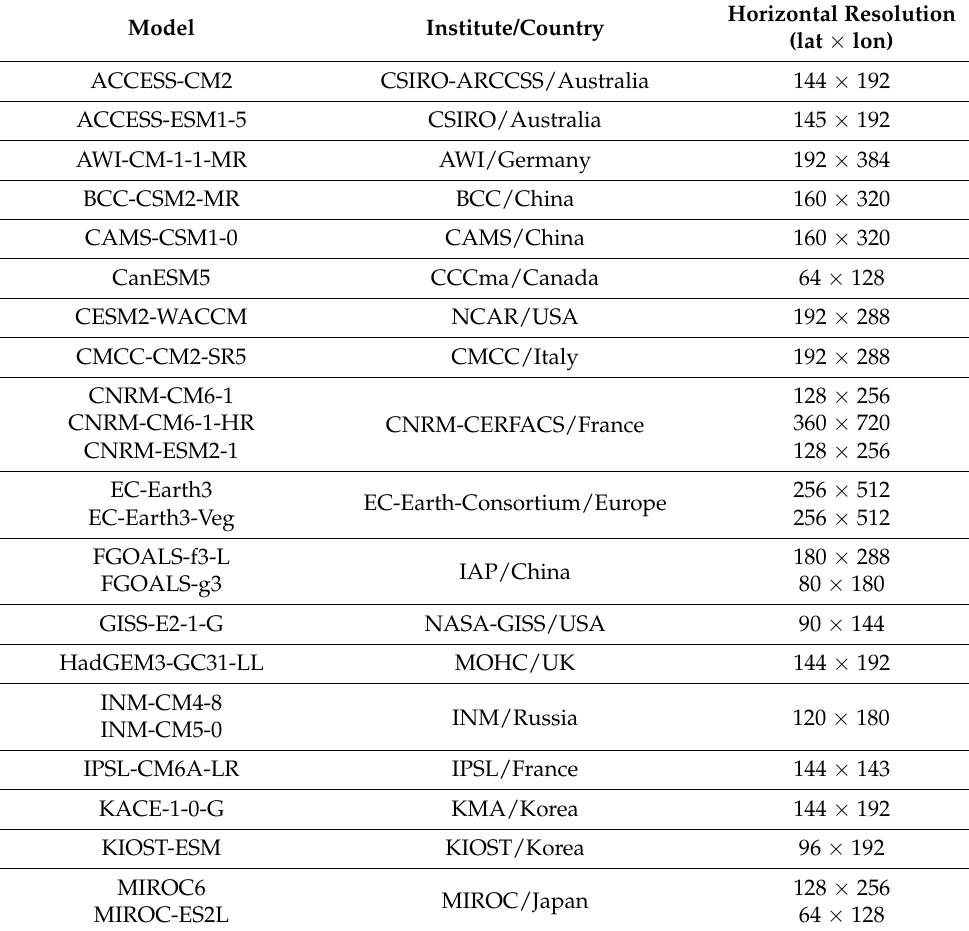
Table 1. Information regarding the CMIP6 models’ name, institute/country, and horizontal resolu- tion used in this study, where lat (lon) meaning latitude (longitude).